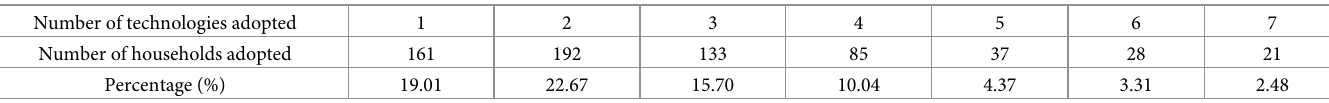
Table 3. Statistics on the number of new agricultural technologies adopted by family farms. Number of technologies adopted